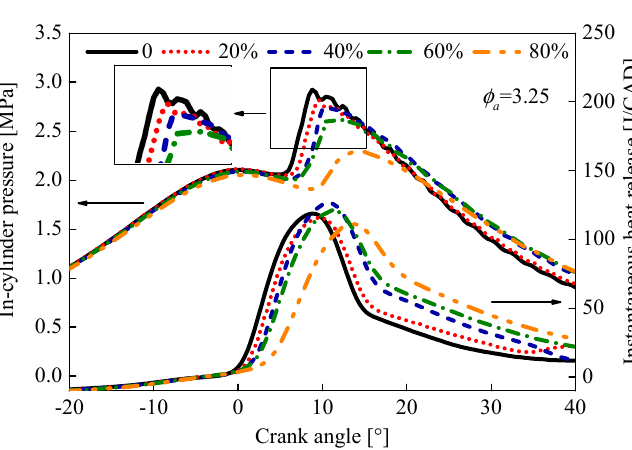
Figure 4. Comparison of in-cylinder pressure and HRR under different substitution rates at ϕ a = 3.25.